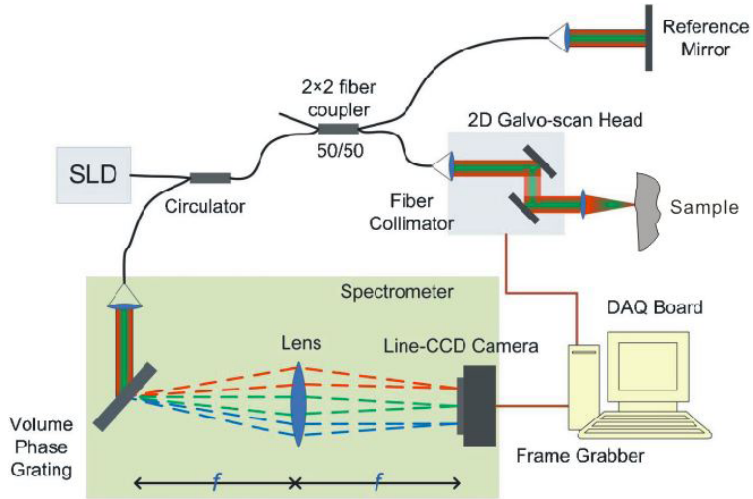
Fig. 3. Schematic diagram of SD-OCT system, which is simulated in our virtual